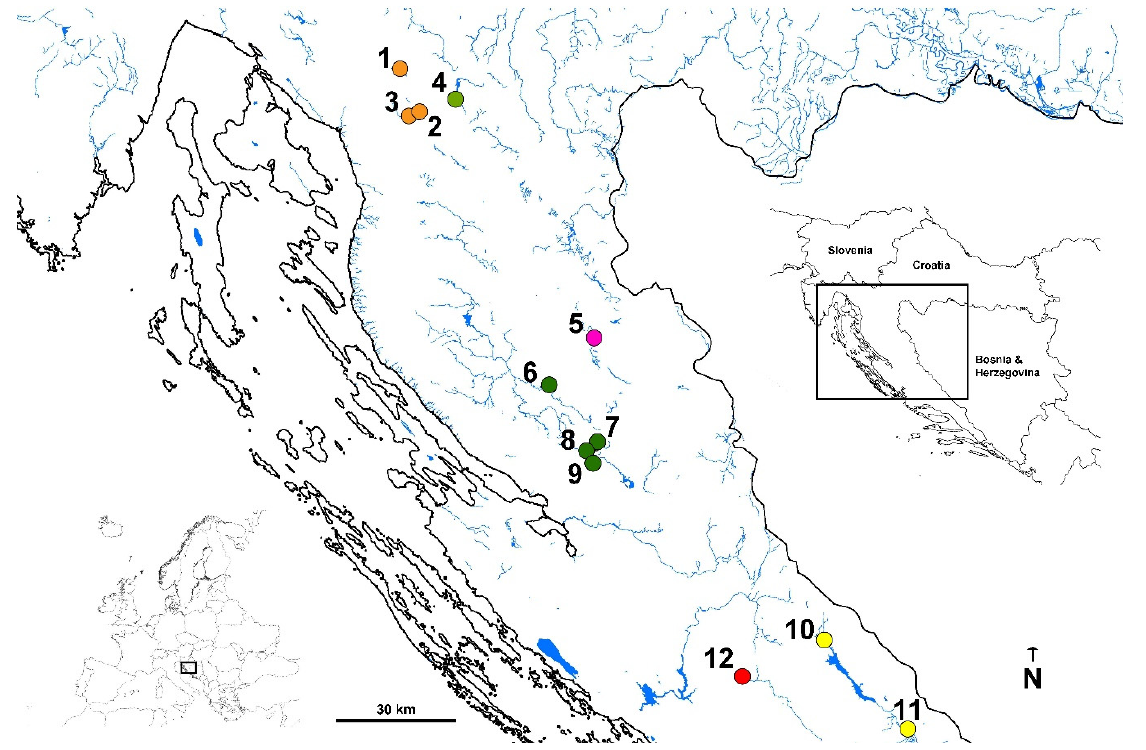
Figure 1. A map of the investigated area, with marked distribution ranges of the investigated Telestes species and sampling localities: (1) Jasenak field, (2) Studenac, (3) Sušik, (4) Šmit Lake, (5) Krbavsko field, (6) Jadova, (7) Suvaja, (8) Riˇcica, (9) Obsenica, (10) Vinali´c, (11) Cetina, and (12)